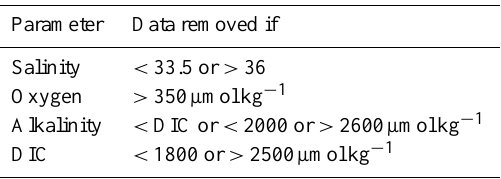
Table 2. Initial quality control on the GLODAP and CLIVAR data. Parameter Data removed if